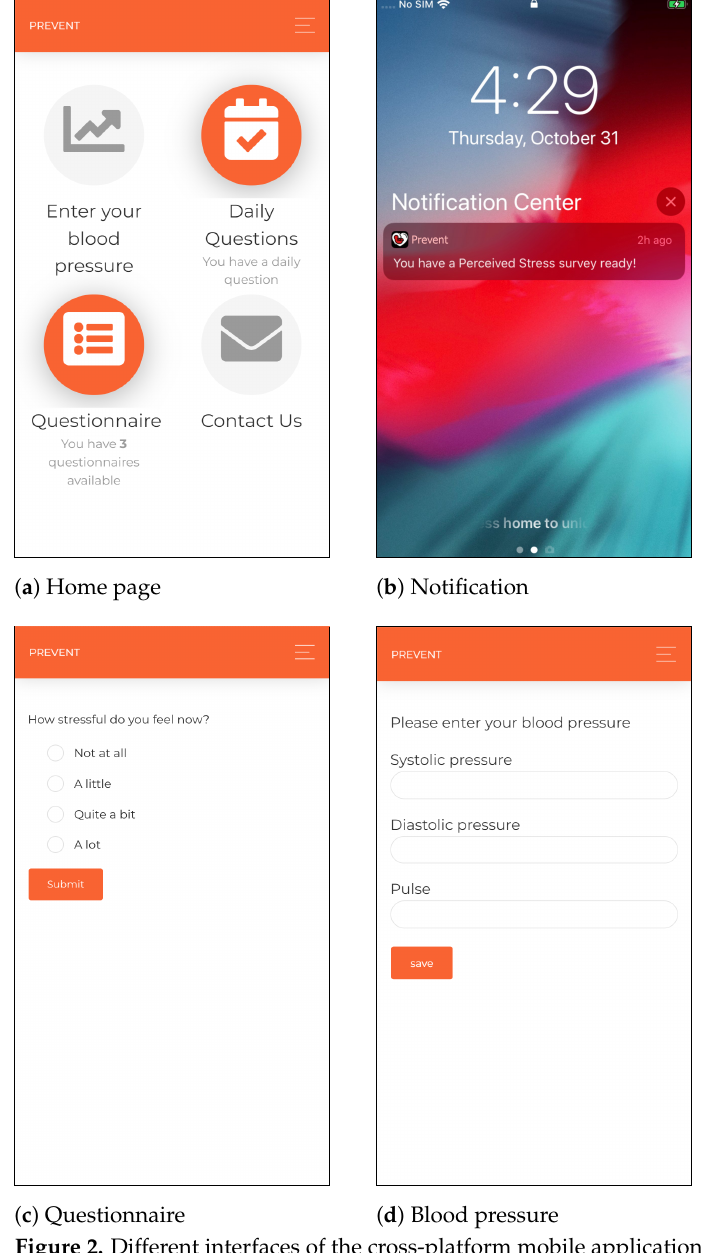
Figure 2. Different interfaces of the cross-platform mobile application leveraged in our